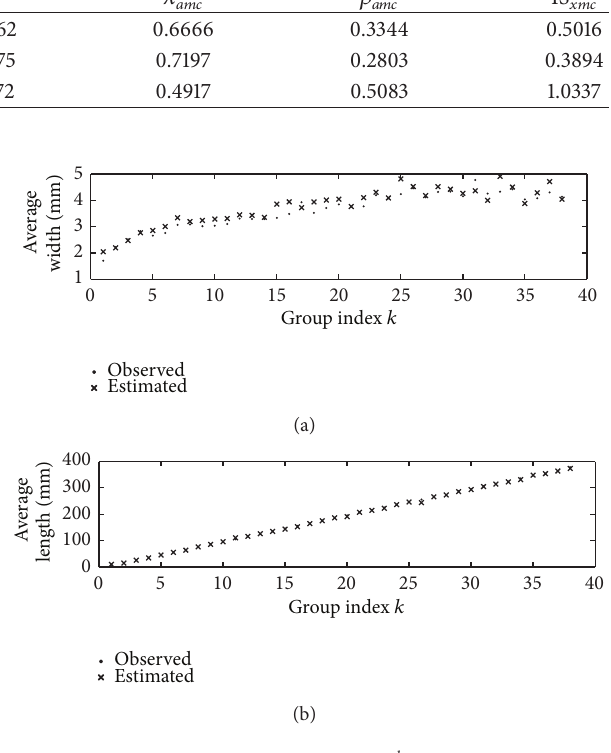
𝑘 𝑜 and image estimated 𝐺 (𝑙) . (b) Comparison of 𝑘 𝑙 𝑘 𝑑 length averages taken over